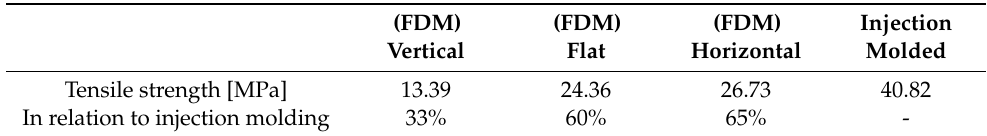
Table 2. Results of the tensile tests for the samples printed with different orientation and injection molded reference samples.